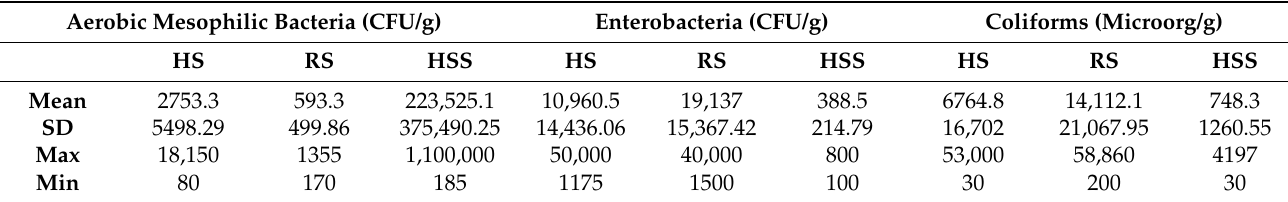
Table 1. Data set for microbiological